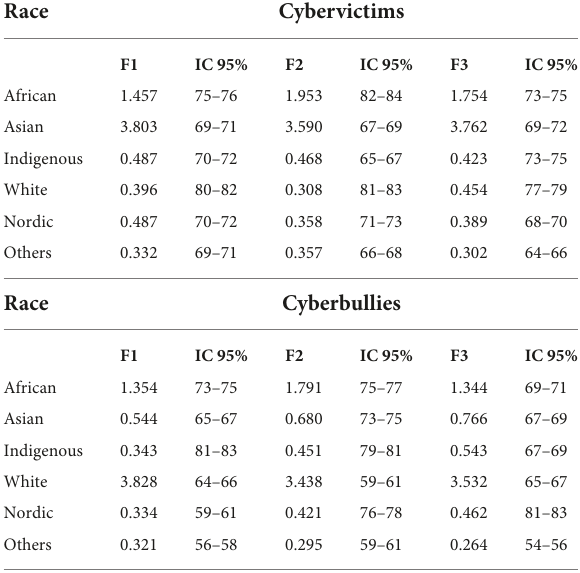
TABLE 6 Kruskal–Wallis H -test for cybervictims and cyberbullies according to race.